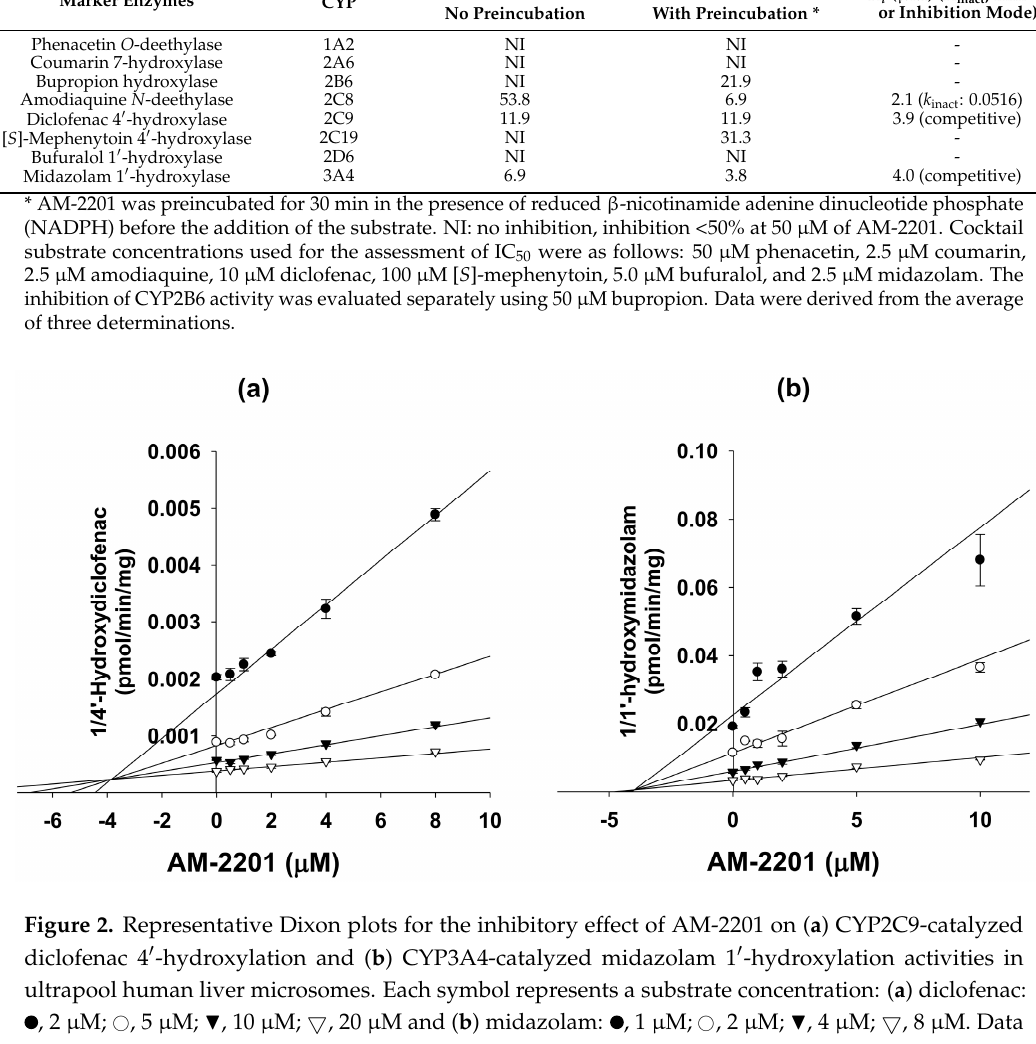
Table 1. Inhibitory effect of AM-2201 on major CYP metabolic activities in human liver microsomes. Marker Enzymes